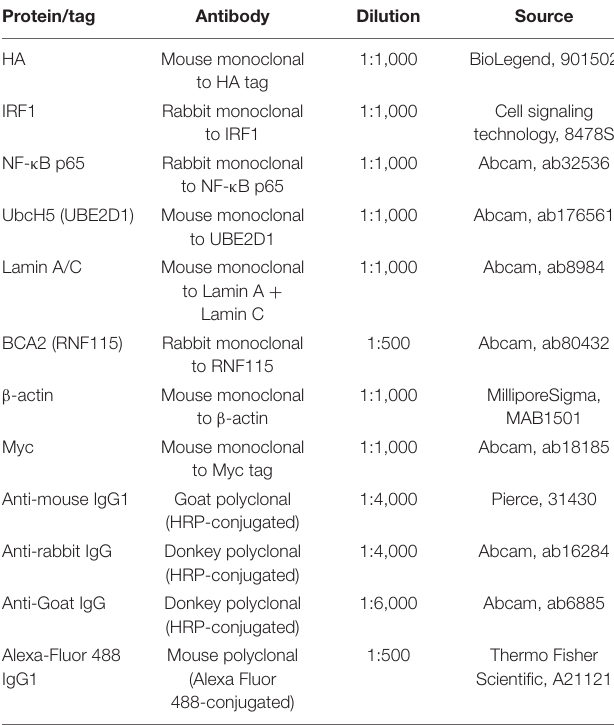
TABLE 1 | Antibody sources and conditions. Protein/tag Antibody Dilution